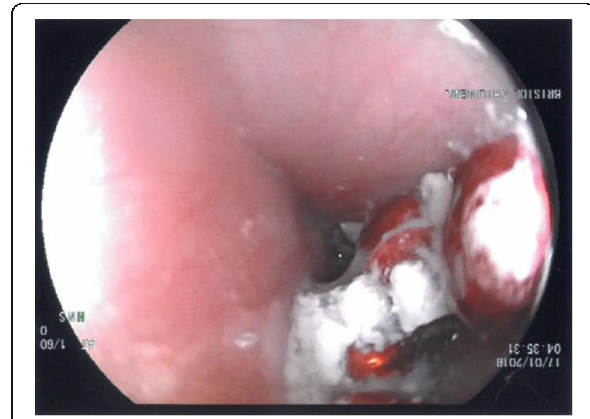
Fig. 4 Endoscopic extraction of the ingested Buckyball magnets using the basic magnetic retriever alongside endoscopic